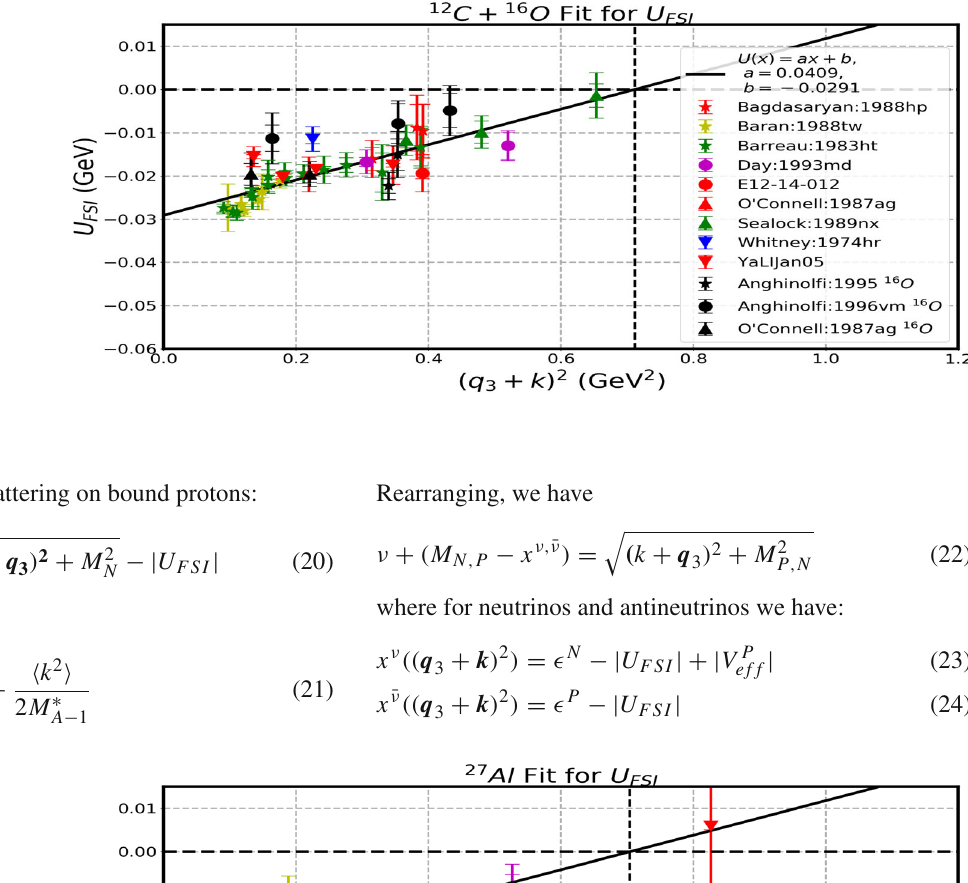
Fig. 17 Extracted values of U FSI versus ( q 3 + k ) 2 for 33 Carbon ( 12 C) and 8 Oxygen 6